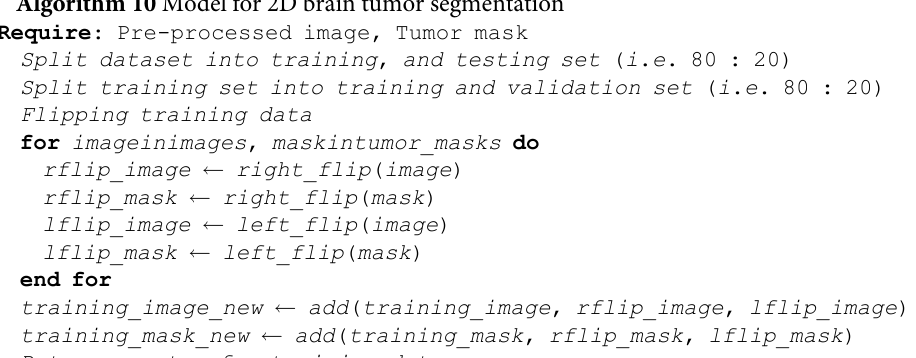
Algorithm 10 Model for 2D brain tumor